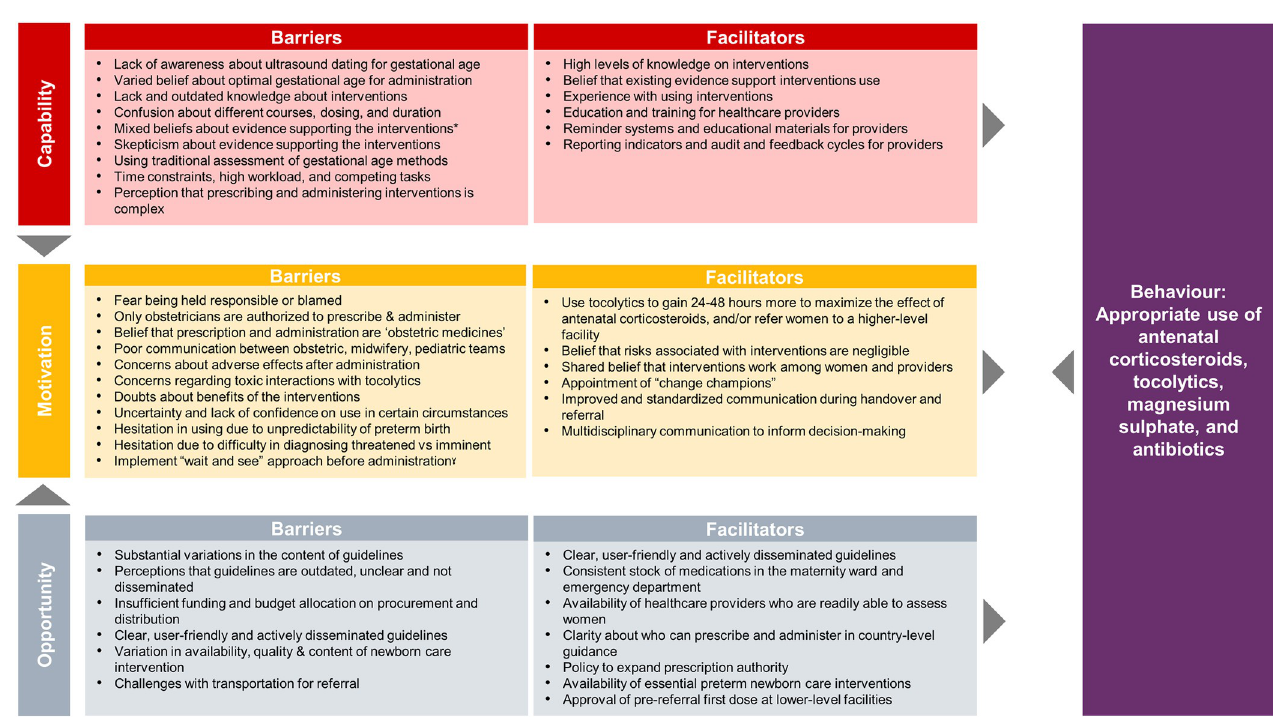
Fig 4. Mapping factors affecting health providers’ appropriate use of interventions for preterm birth management using COM-B. � = mixed evidence, could be facilitators and barriers; γ = barriers for ACSs and magnesium sulphate, yet facilitators for tocolytics.